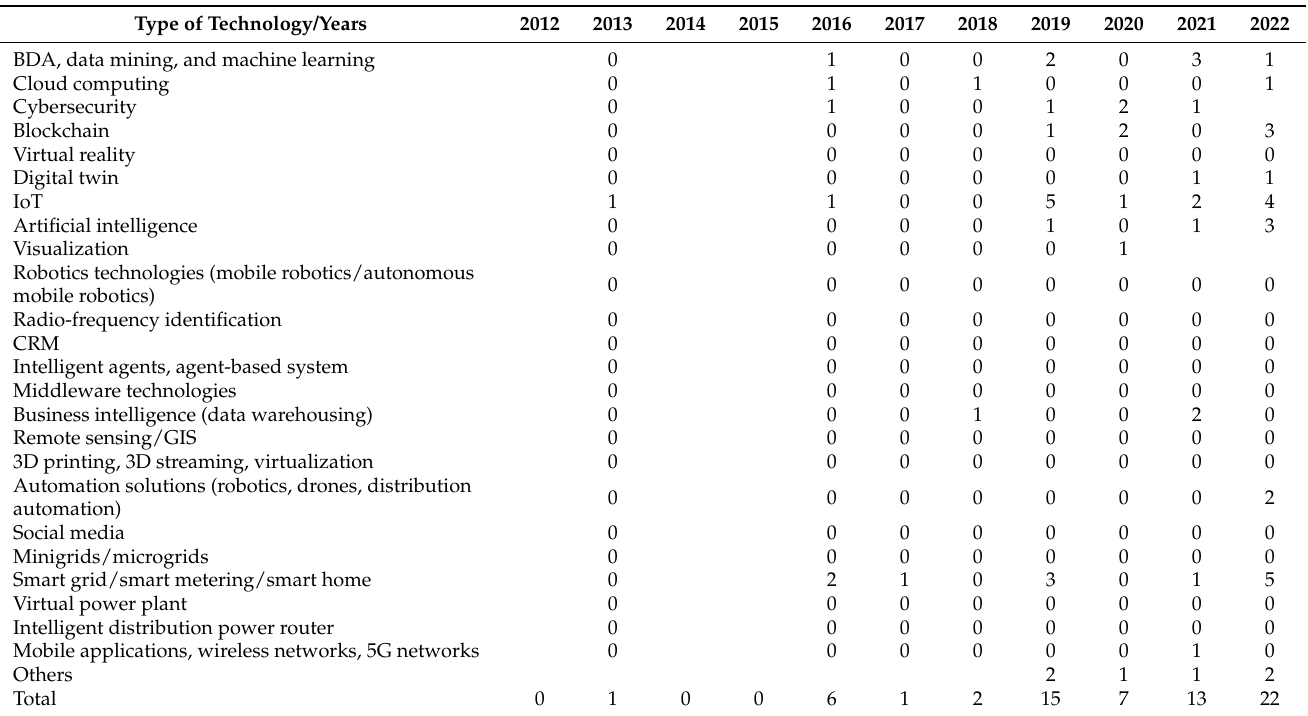
Table 10. The number of articles focused on technologies used for digitalization indexed annually in Scopus during 2012–2020 1